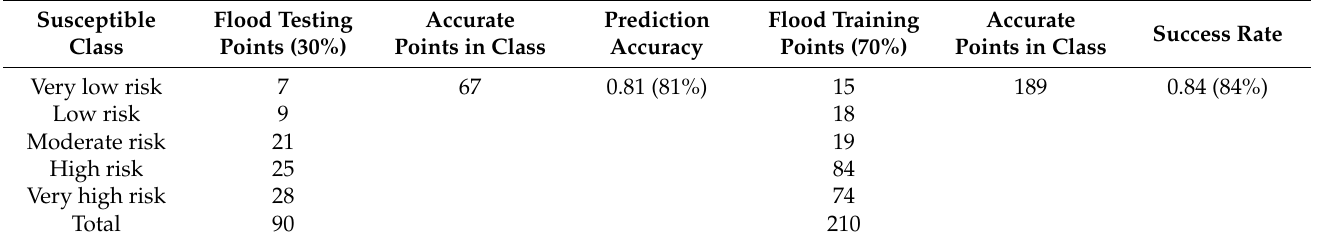
Table 5. Flood susceptibility mapping estimation of prediction accuracy and success